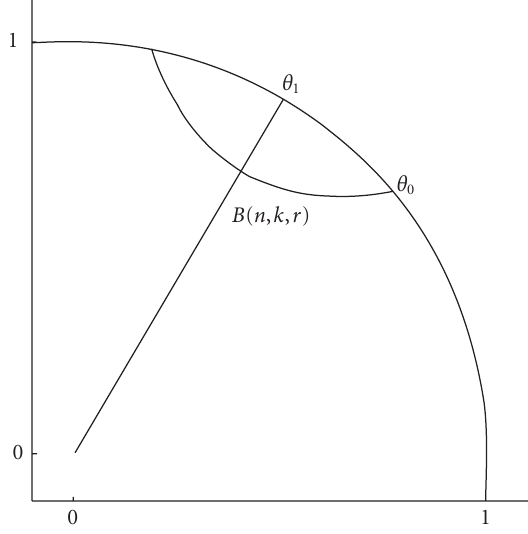
Figure 3.1 . Trinomial arc defined for feasible angles θ ∈ ( θ 0 , θ 1